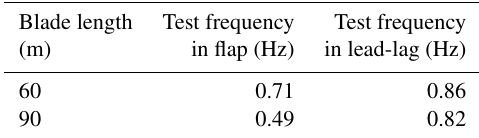
Figure 7. Scaled trend of blade mass and length. Table 1. Representative blade